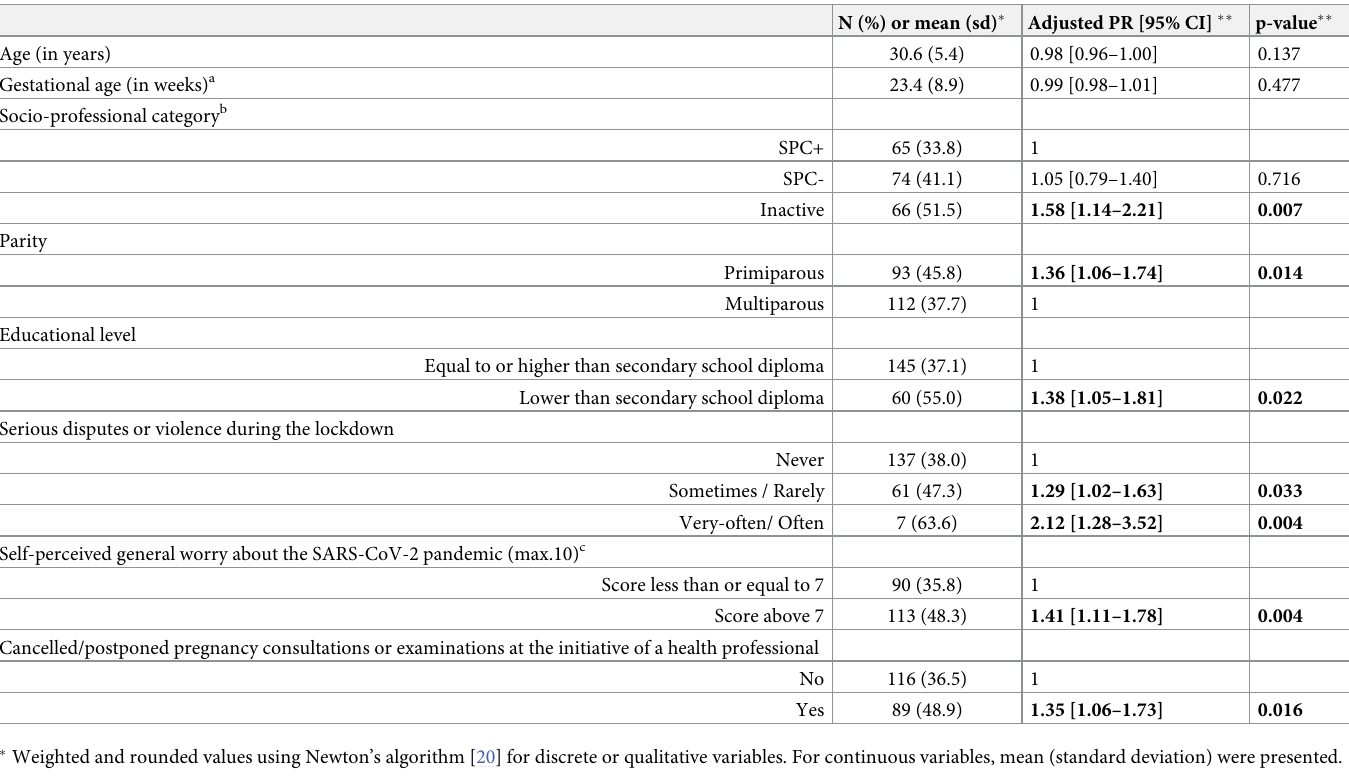
Table 2. Factors associated with an unmet need to communicate with a healthcare professional about course of pregnancy or childbirth during the first SARS-CoV- 2 pandemic lockdown, Covimater survey (n = 500), France (July